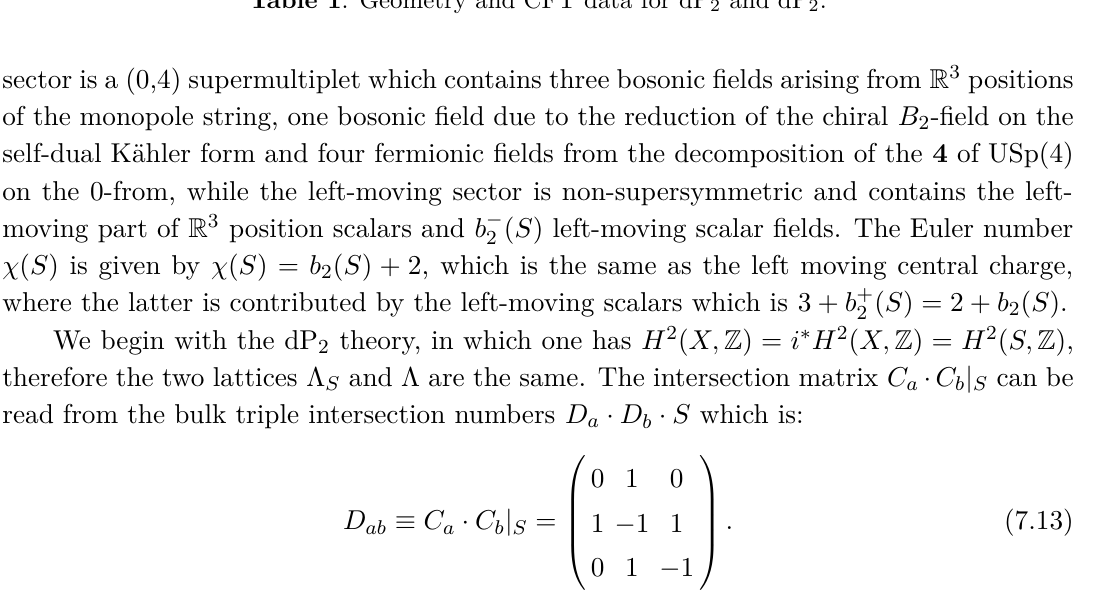
Table 1 . Geometry and CFT data for dP 2 and f dP 2